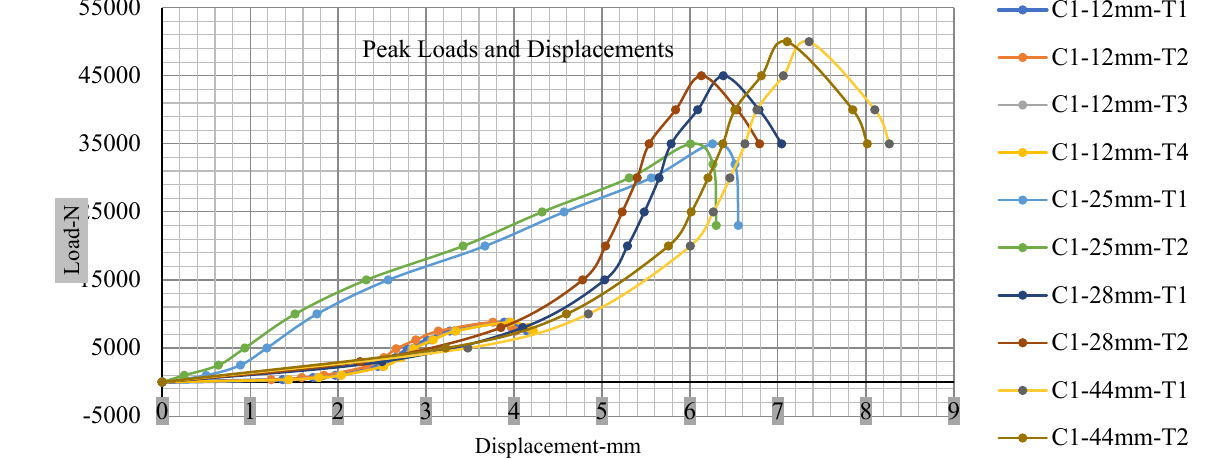
Figure 18. Cell 1 peak loads and displacements.